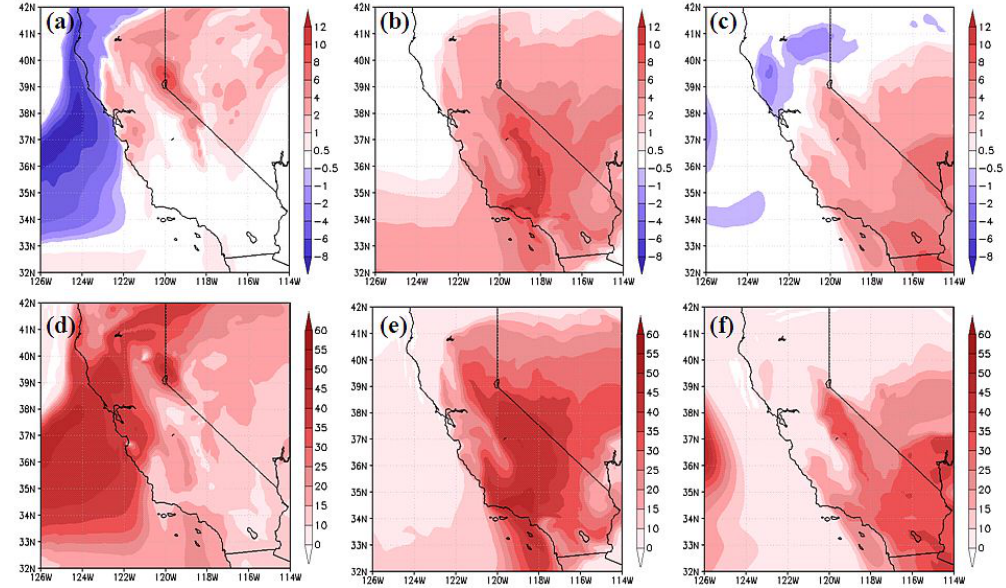
Fig. 16. Surface O 3 (a–c) and CO (d–f) difference (Base case – Obs case) over California from 12km model simulations at 18:00UTC on 22 June (a; d), 23 (b; e) and 24 (c;